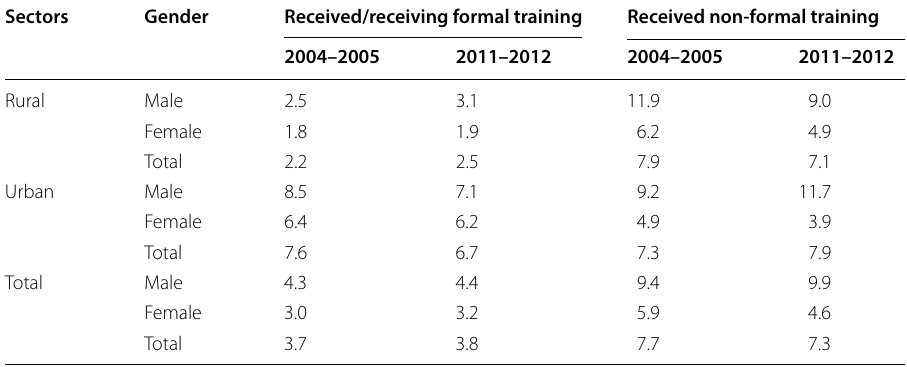
Table 2 Population who received/are receiving vocational training per 100 persons (15– 29 years of age)—changes over time. Source: NSSO (2015) and NSSO (2006) Sectors